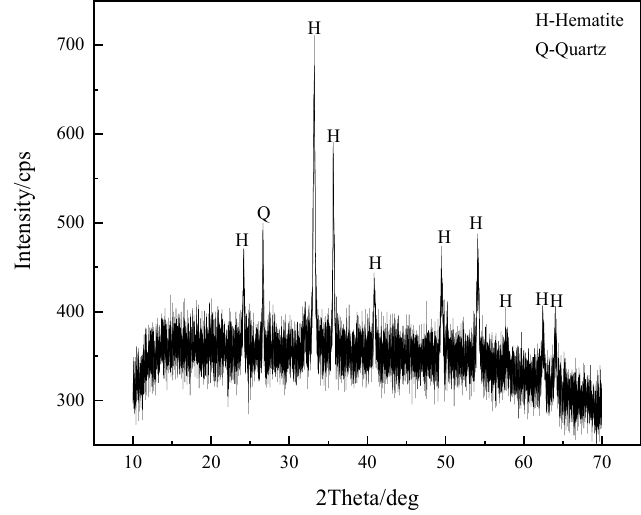
Figure 1. XRD pattern of HPOHO. Table 2. Occurrence of iron in HPOHO.